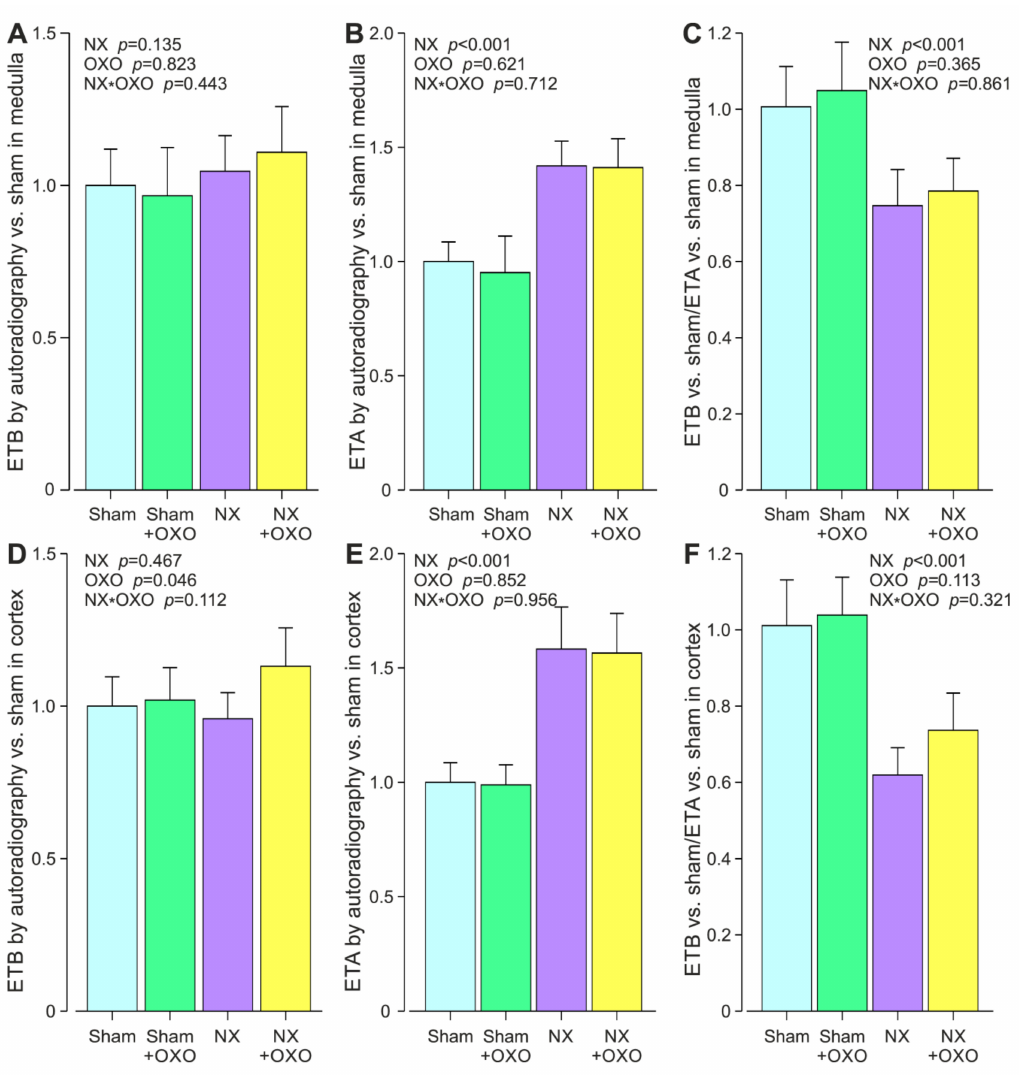
Figure 1. Kidney medullary ETB ( A ) and ETA ( B ) receptor protein content, and the ETB:ETA protein ratio ( C ); and kidney cortical ETB ( D ) and ETA ( E ) receptor protein content, and the ETB:ETA receptor protein ratio ( F ) quantified using autoradiography in the twelve-week 5 / 6 nephrectomy model; NX, 5 / 6 nephrectomy; Sham, sham-operation; OXO, 2.0% oxonic acid diet; n = 12 / group. Values are mean ± 95% confidence interval of the mean. Two-way ANOVA p -values for NX, OXO and their interaction are presented in the